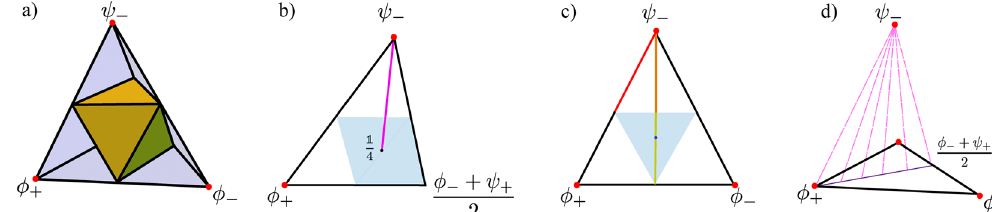
Figure 6. Bell-diagonal state tetrahedron representation. ( a ) The blue tetrahedron is the entire set of Bell- diagonal states. The Bell states sit at the vertices of the tetrahedron indicated by the red dot. The yellow octahedron is the class of separable states corresponding to the condition separable states represents the entangled states. ( b , c ) are the Schematic representation of two slices from the Bell-diagonal space. The lines connecting the centre of T and the vertices are maximally entangled states with added white noise. In ( b ), we represent the special case of Werner states (magenta line) where the maximally entangled state is the Bell singlet. ( c ) Represents one of the faces of the tetrahedron. The face represents the rank 3 states and its edges represent the rank 2 states in the Bell diagonal space. The red line corresponds to the edge states, the orange line represents the type I face states and yellow line, the type II face states. The blue shading represents the separable region on that face. ( d ) depicts the dotted pink lines that represent the rank 4 Bell- diagonal states which are the convex combinations of the maximally entangled Bell state ψ